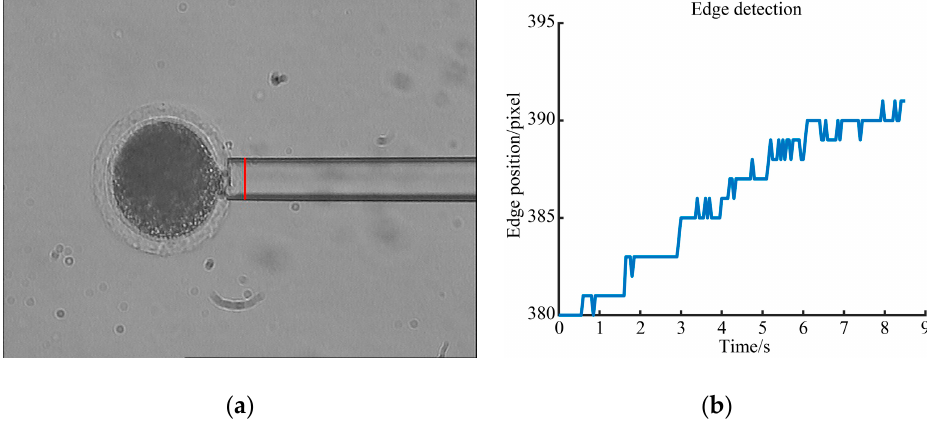
Figure 12. Oocyte aspiration. ( a ) Oocyte aspiration for measuring its Young’s modulus; ( b ) Oocyte edge position in the measuring process.